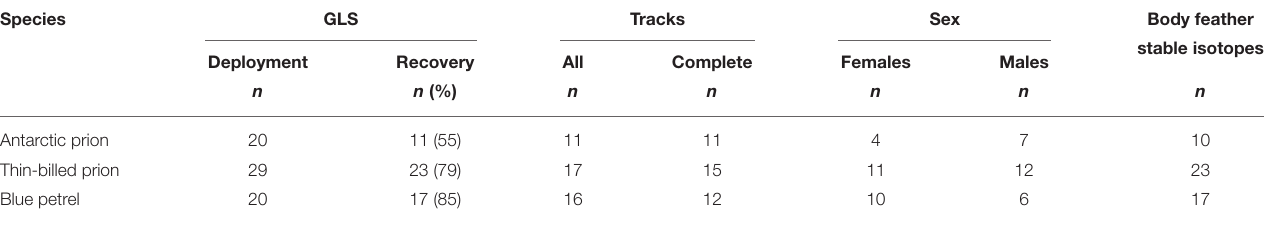
TABLE 1 | Sample sizes of birds at geolocator (GLS) deployment and recovery, and for feather stable isotope analysis, and number of females and males and of analyzed GLS tracks. Species GLS Tracks Sex Body